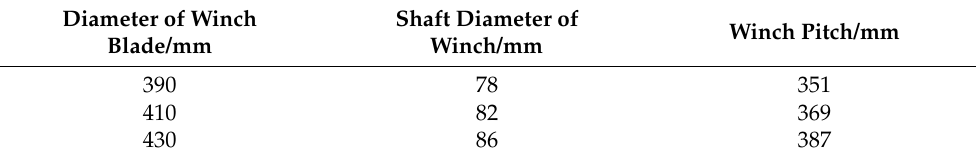
Table 1. Parameter values of extrusion-forming